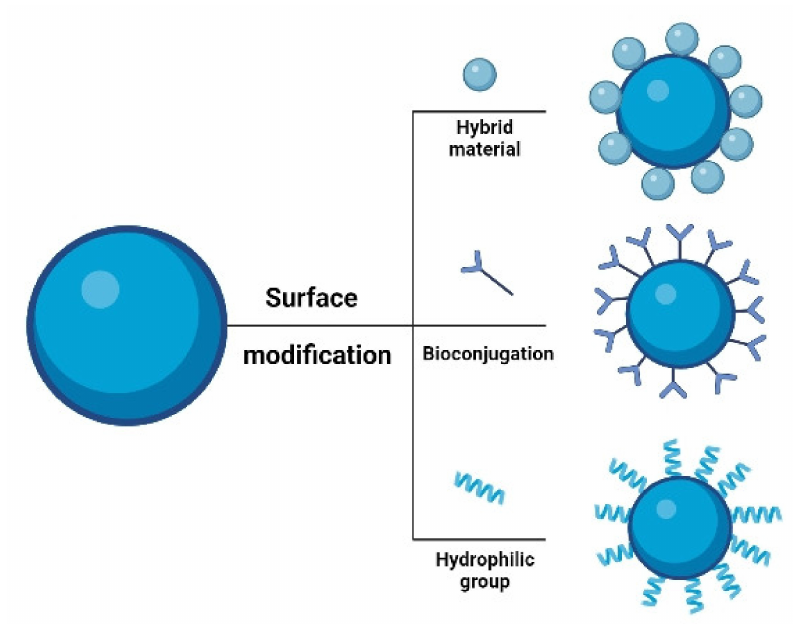
Figure 5. Surface modification of UCNPs for modulating its